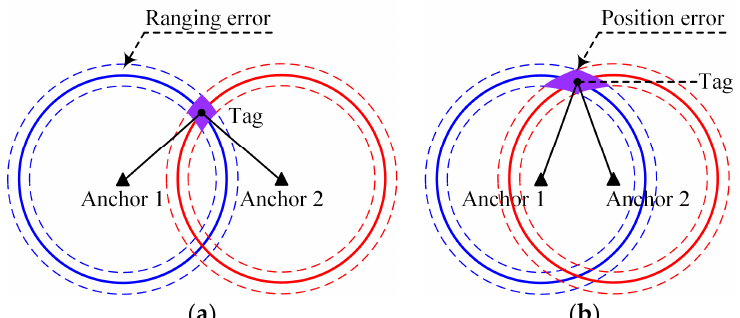
Figure 3. Geometric distributions of the UWB anchors: ( a ) good geometric distribution and ( b ) poor geometric distribution.